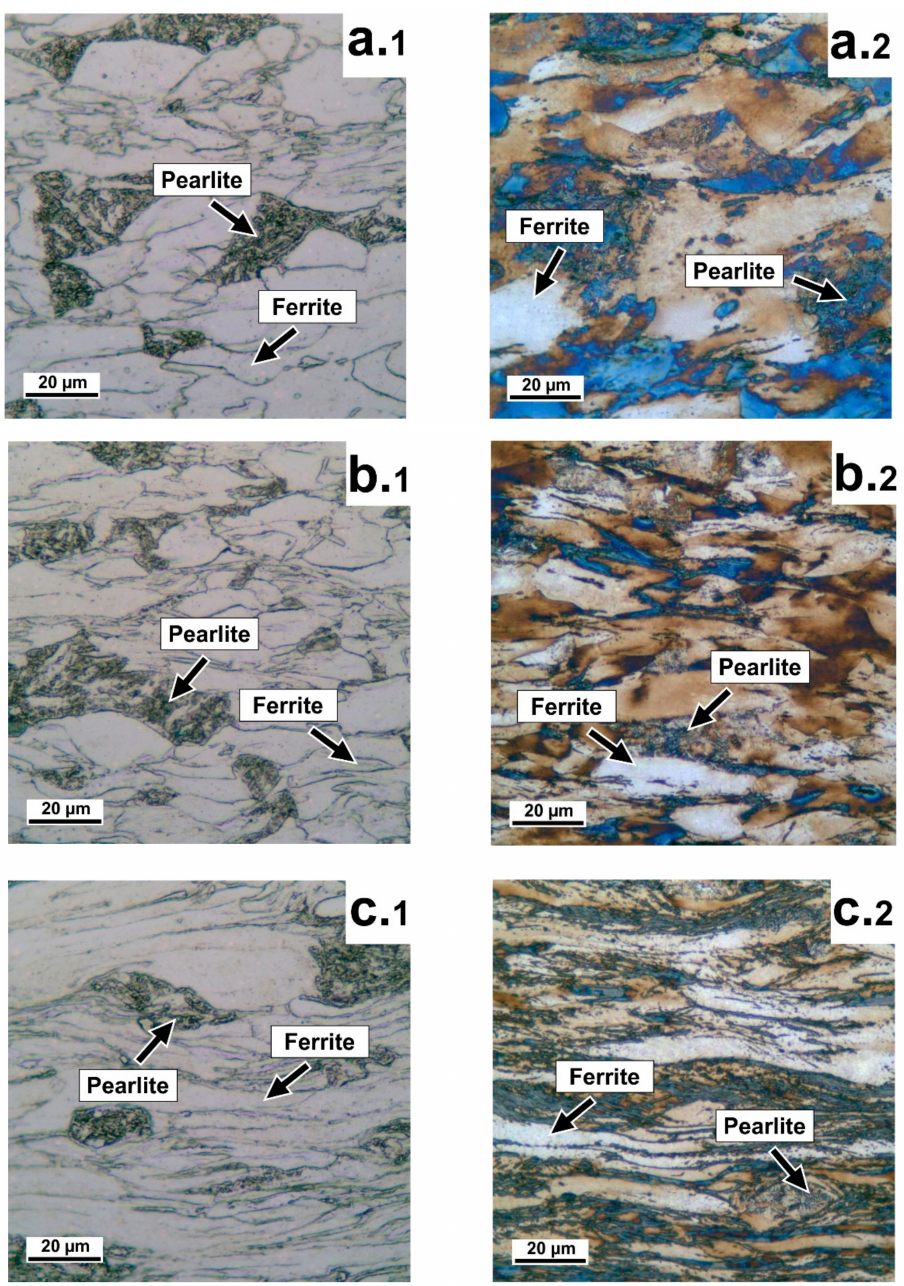
Figure 3. Microstructural observations using an optical microscope, at different degrees of deforma- tion compression: ( a.1 – c.1 ) Nital etching; ( a.2 – c.2 ) Klemm etching; ( a ) 50%; ( b ) 60%; ( c )